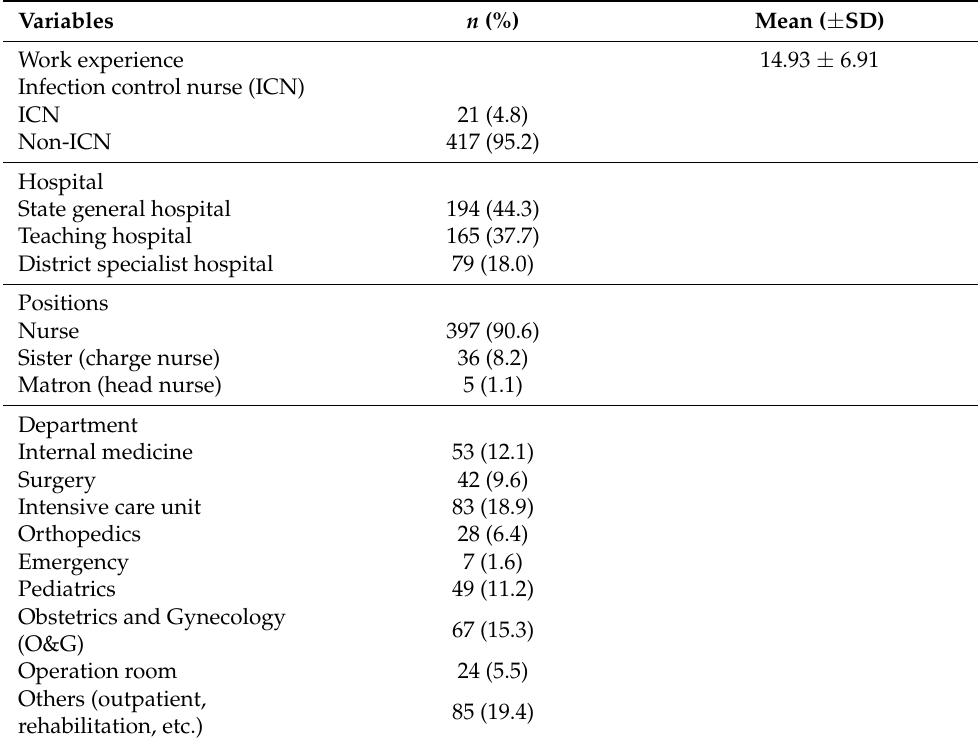
Table 2. Work characteristics of participants ( n =